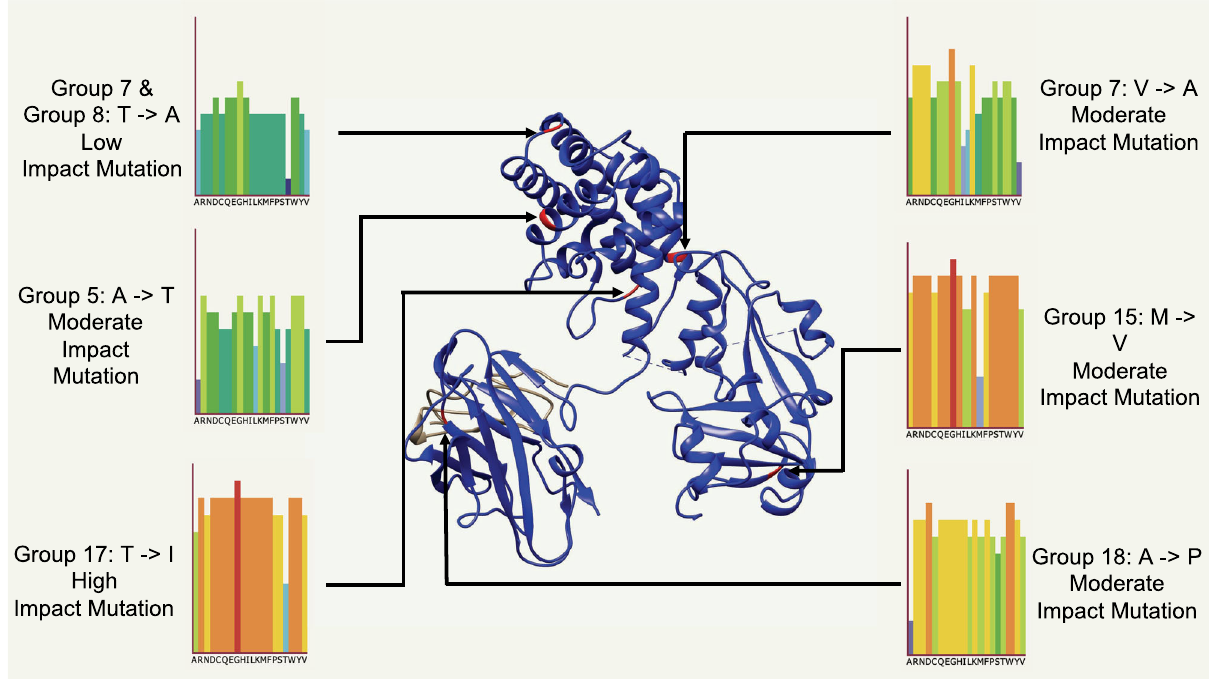
Fig. 2 Six non-synonymous mutations plotted onto diphtheria toxin model 1XDT (https://www.rcsb.org/structure/1xdt) from the Protein Data Bank using PHYRE2. The impact of these mutations is estimated by SuSPect, with a gradient per mutation of low (dark blue) to high (orange/red).